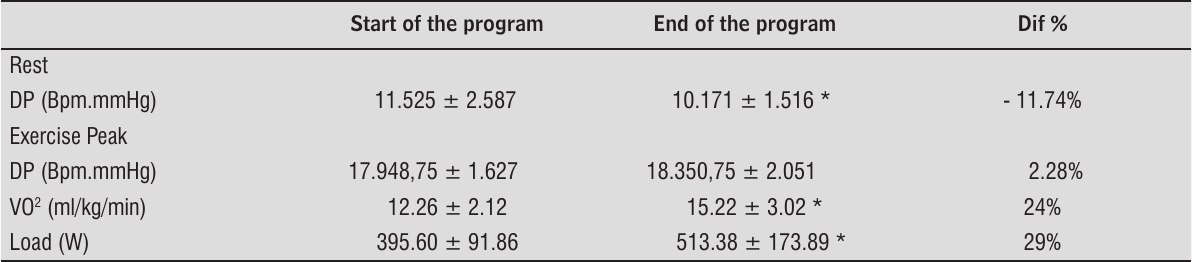
Table 2 – Effect of the LMP in the cardiac demand, oxygen uptake and workload Start of the